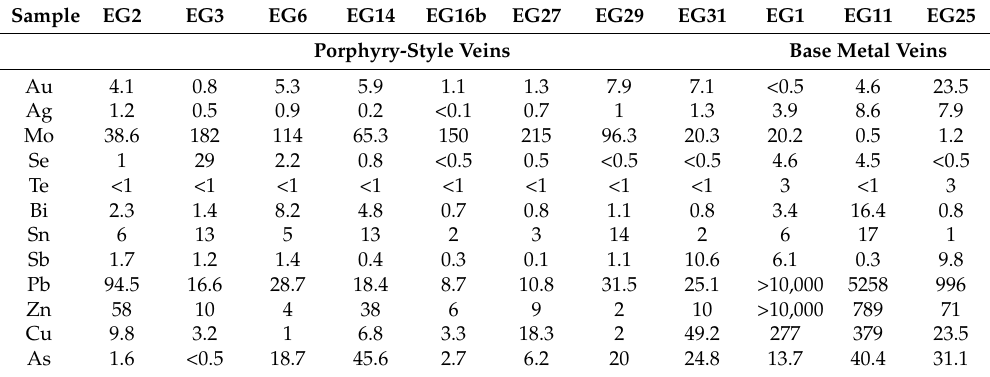
Table 5. Selected bulk-ore trace elements analyses (acquired by ICP-MS) from porphyry-style and base metals veins from the Aisymi-Leptokarya prospect. Concentrations are in ppm, except for gold in